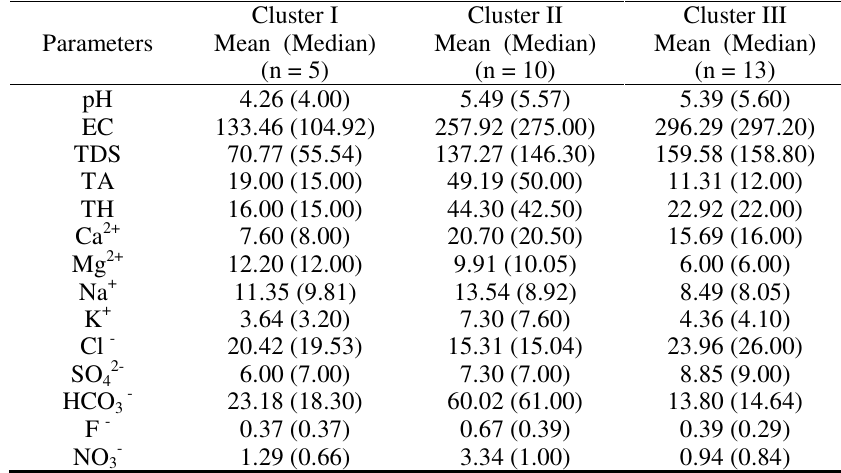
Table 5. Summary statistics of the revealed clusters.